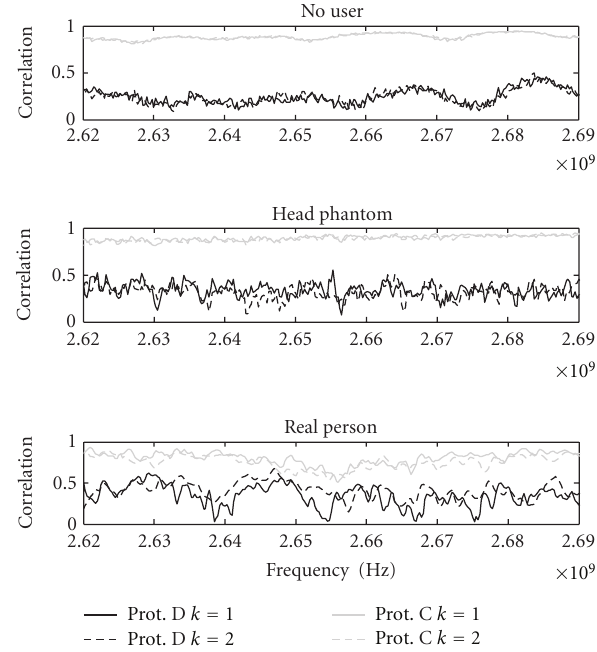
Figure 4: Correlation of the 2600 MHz band devices for the three di ff erent